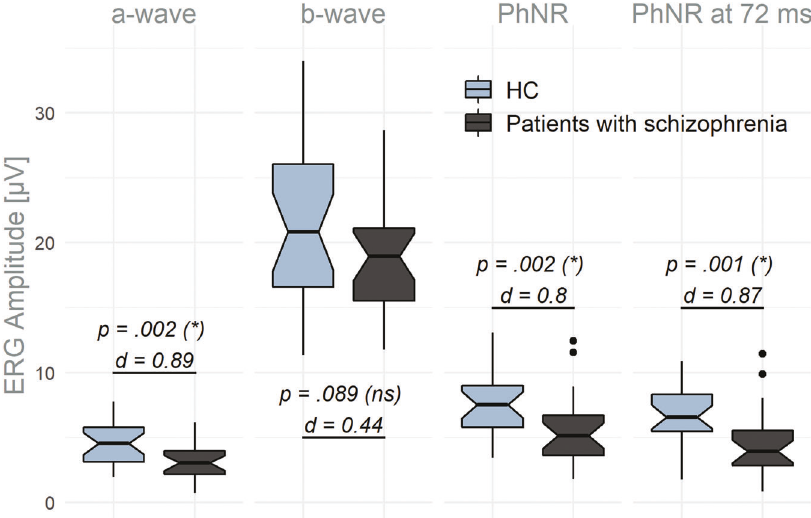
Fig. 2 ERG amplitudes ( μ V) for HC and patients with schizophrenia. P -values of the one-sided Wilcoxon tests with Bonferroni – Holm- corrected signi fi cance levels in parentheses and Cohen ’ s d ( d ). d Cohen ’ s d, HC healthy controls, ns not signi fi cant, * signi fi